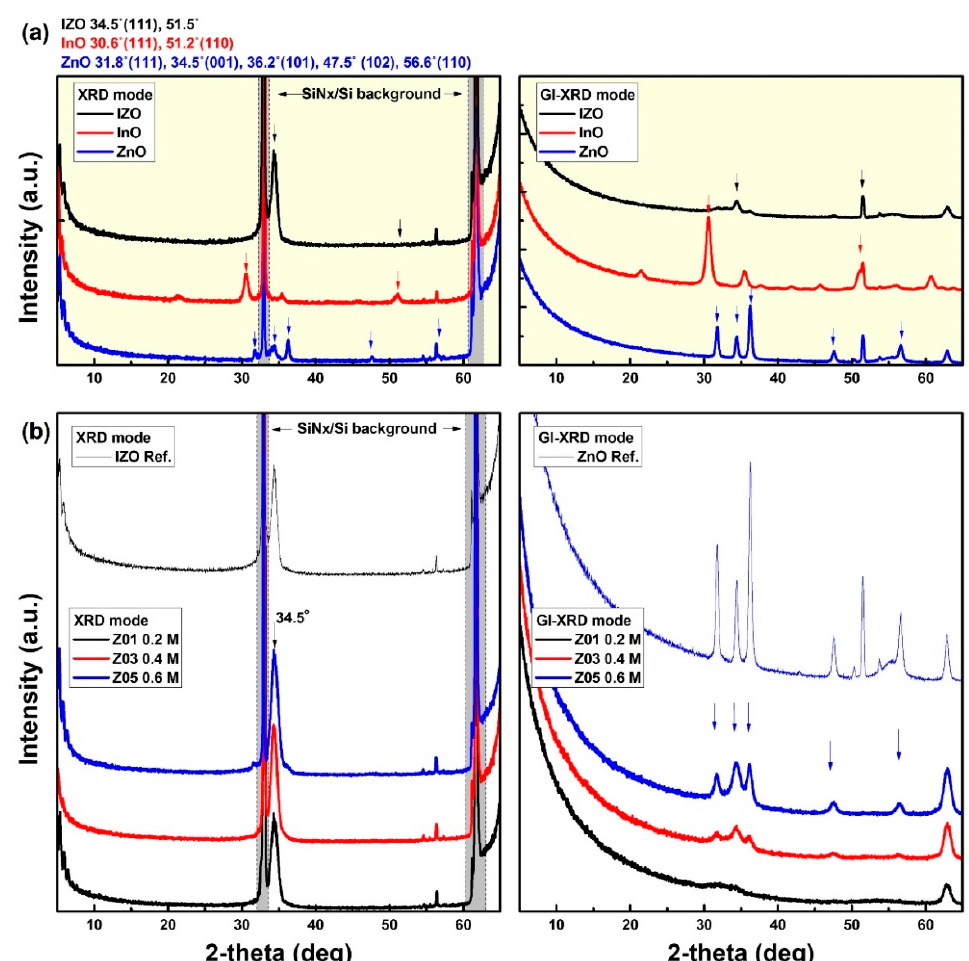
Figure 3. XRD graph to analyze the crystallinity of a -IZO films. ( a ) Reference peak analysis of IZO, InO and ZnO films. ( left ) Crystallinity of bulk film measured in 2- θ mode. ( right ) Surface crystallinity measured in grazing incident (GI) mode. Several reference peaks of IZO, InO, ZnO films are indicated at the top of the graph ( a ). ( b ) ( left ) Bulk and ( right ) crystallinity of the a -IZO films with respect to Zn molarity.